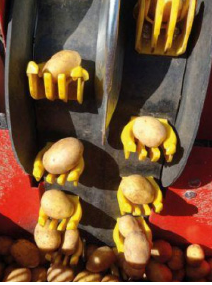
Figure 6. Seed metering belt. Reprinted with permission from ref. [48]. Copyright 2020 Chinese Heilongjiang Agricultural Commission.